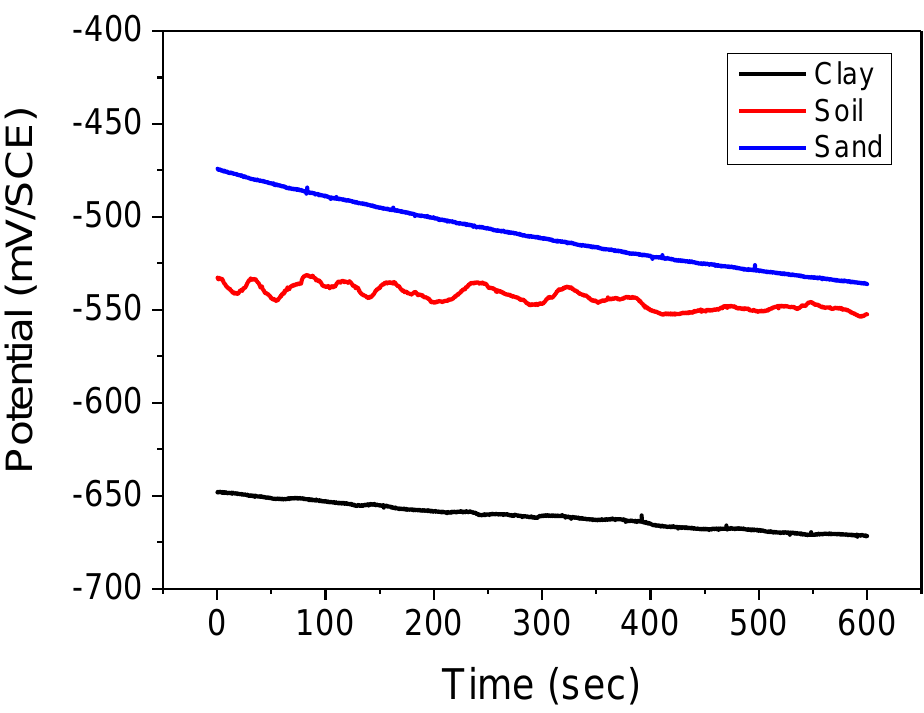
Figure 3. Potential abandonment vs. immersion time for the coated steel in the different soil extracts.